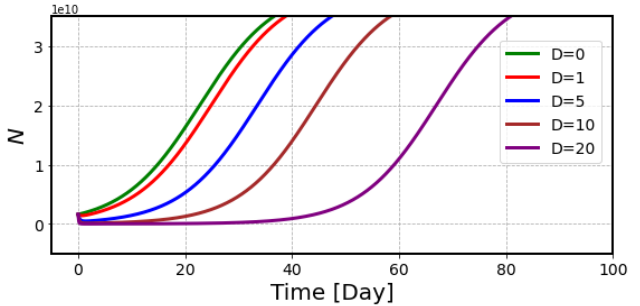
Figure 4. Simulation curves of the number of tumor cells after treatment with 211 At with doses from 1 Gy to 20 Gy. We used λ = 0.14/day, N 0 = 2 × 10 9 , and N m = 4 × 10 10 .